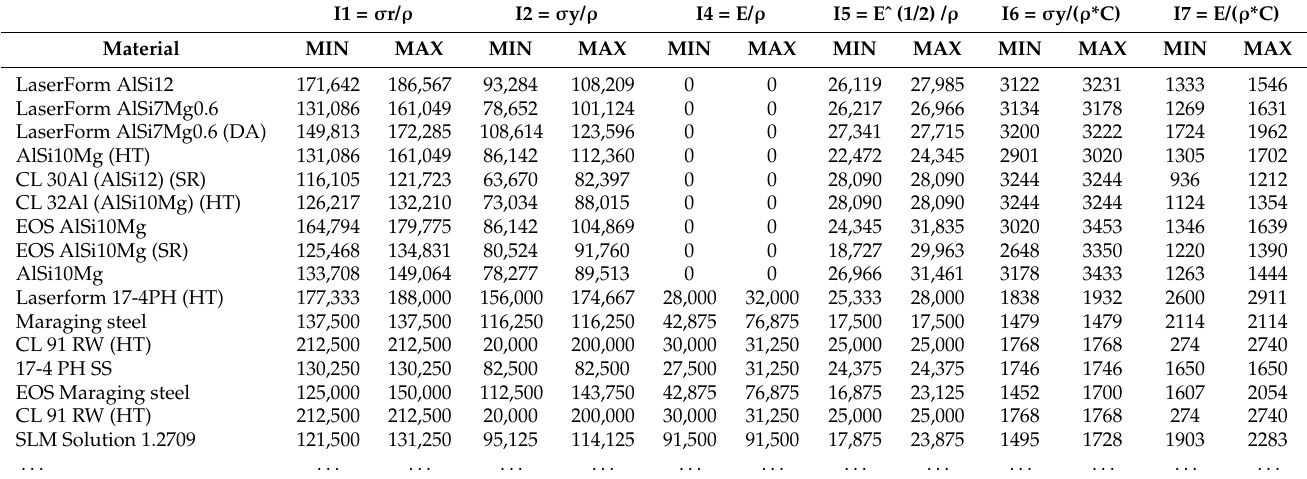
Table 10. Indices values of the compatible materials (index 3 is omitted since it is not significant for aluminium alloys).